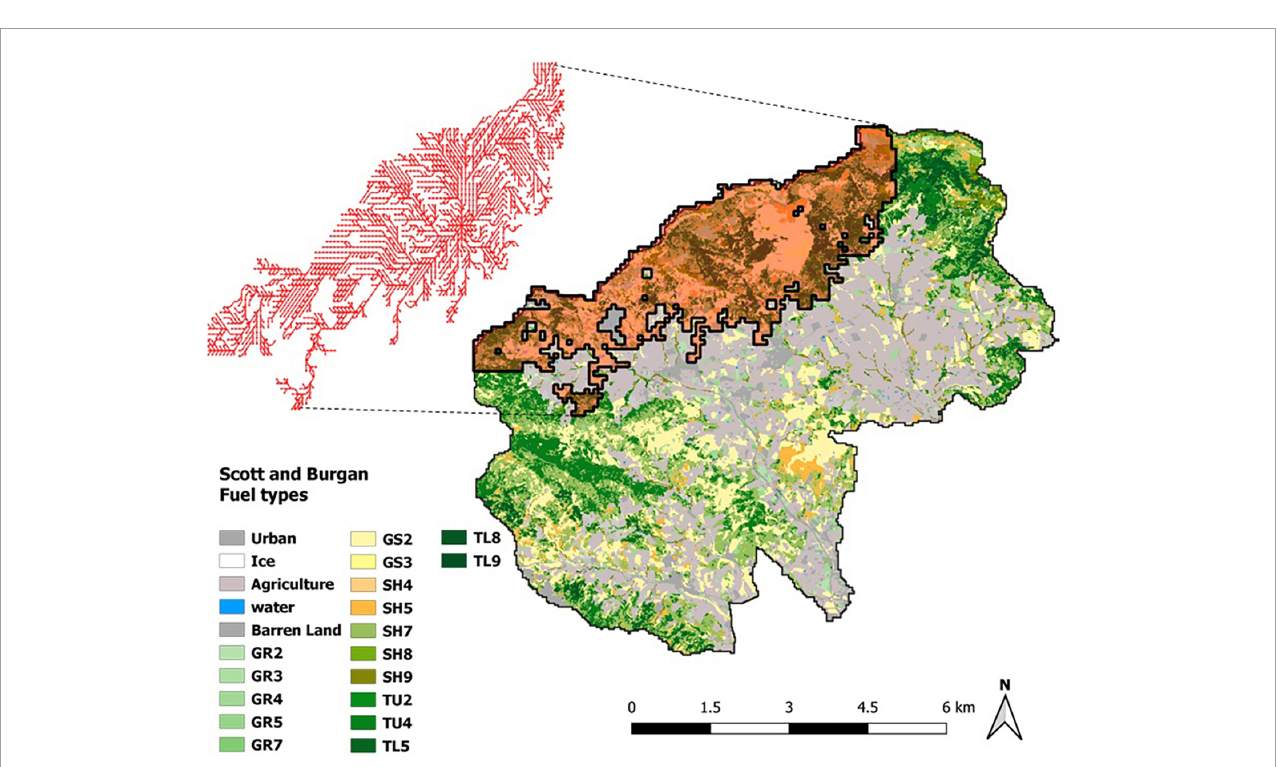
traditional features based on the size and composition of trees in